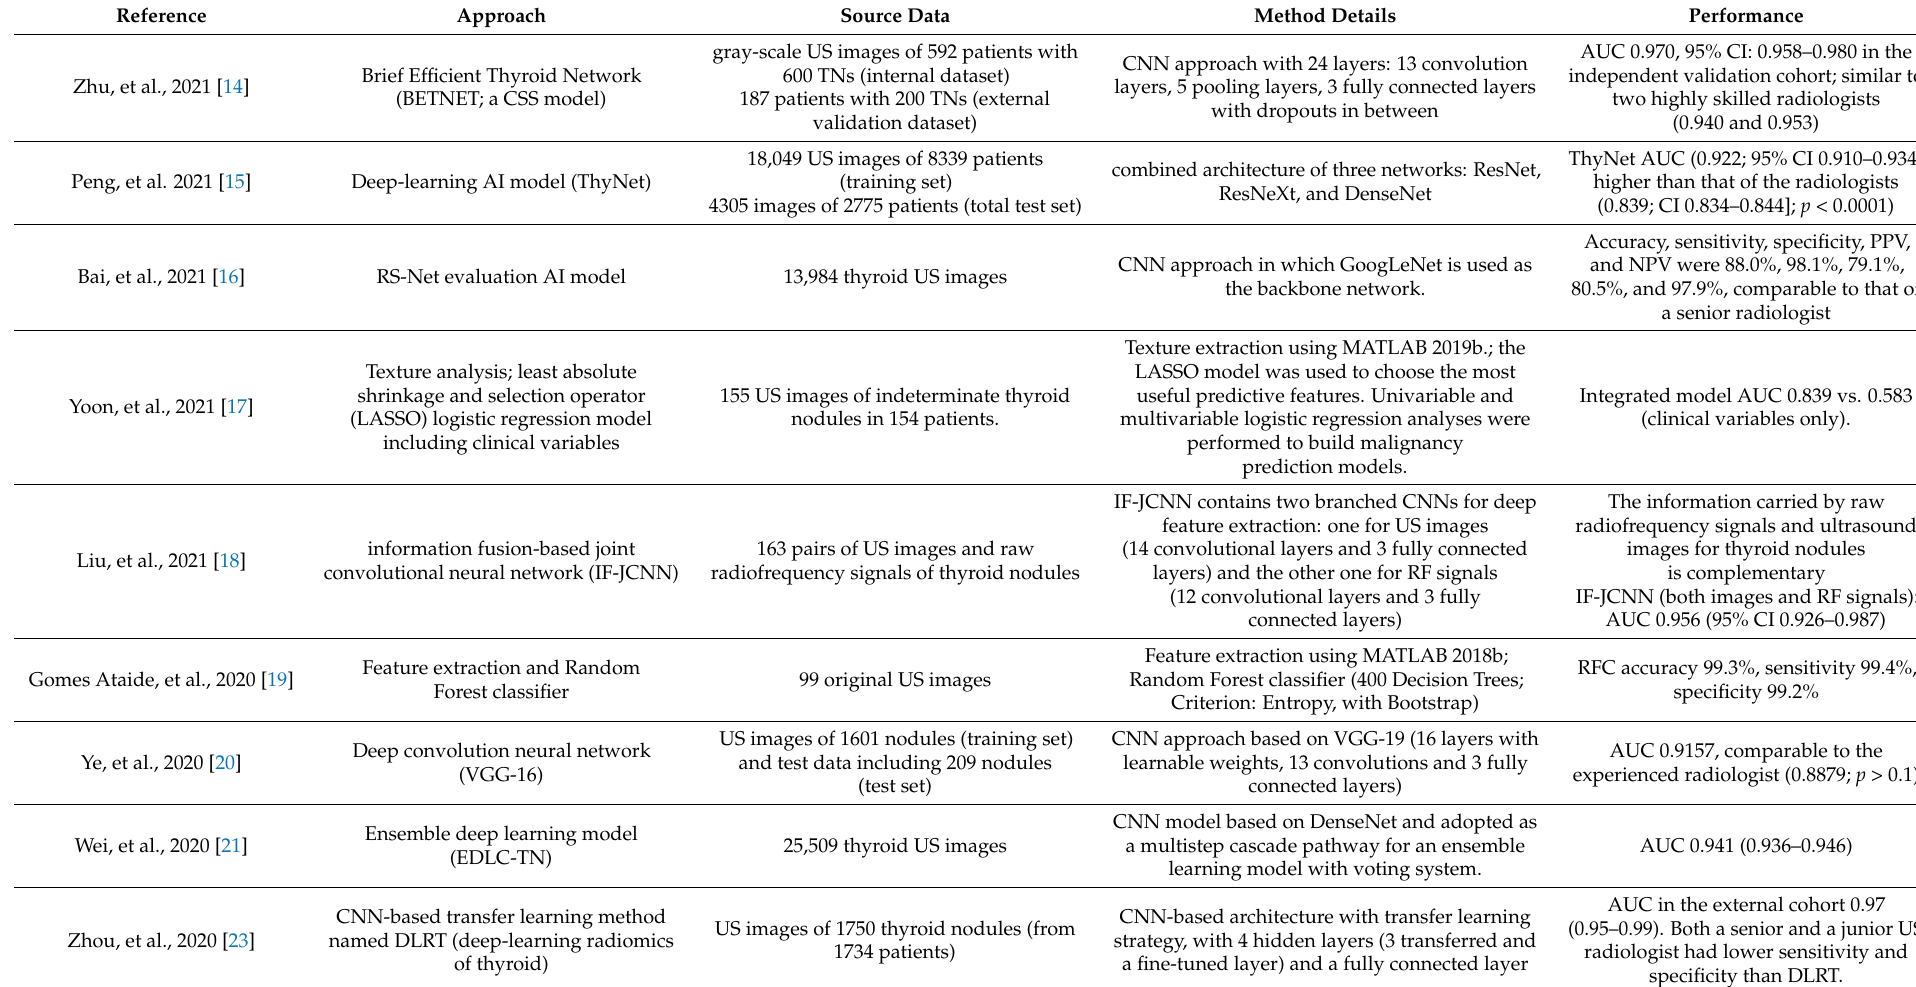
Table 1. Machine learning approaches for the evaluation of thyroid nodule sonographic